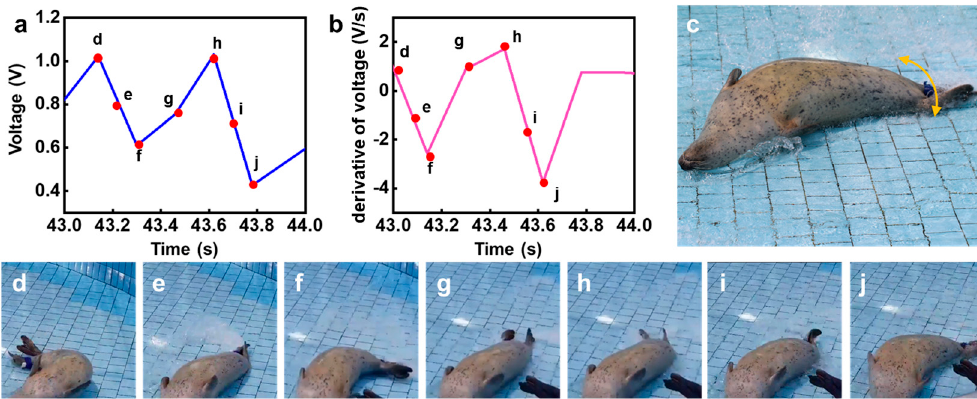
Figure 8. Electrical signals and images describing the flapping behavior of the HS: ( a ) output voltage of the pressure sensor and ( b ) its slope; ( c ) representative image. Images displaying the flapping motion of the seal after ( d ) 0.1 s, ( e ) 0.2 s, ( f ) 0.3 s, ( g ) 0.5 s, ( h ) 0.6 s, ( i ) 0.7 s, and ( j ) 0.8 s.